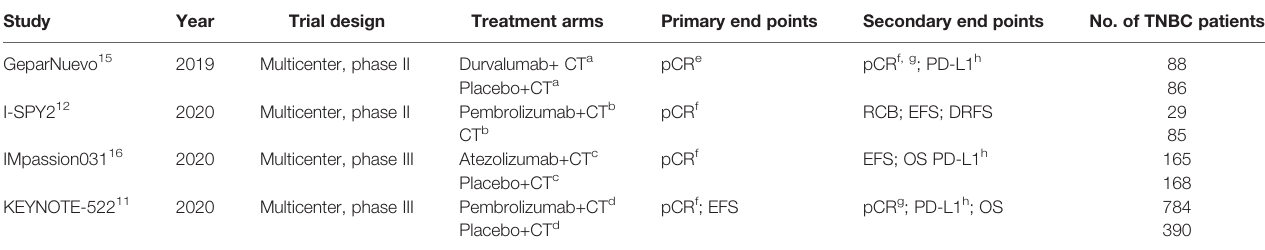
TABLE 1 | Main characteristics of the included randomized controlled trials.